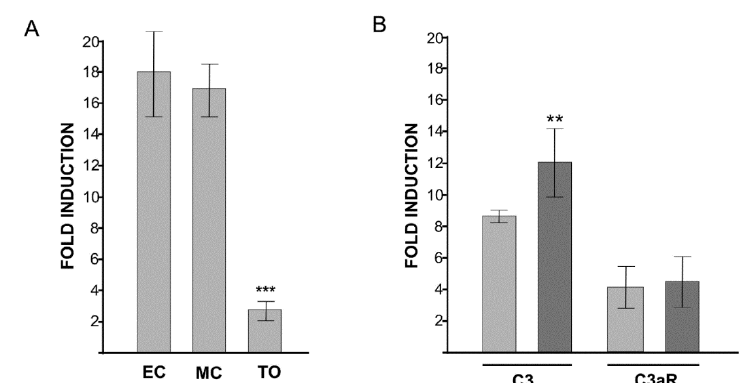
Figure 4. ( A ): level of bsc3a/c5ar transcription product in three phases of the colonial blastogenetic cycle as assessed by qRT PCR. EC: early cycle; MC: mid cycle; TO: takeover. ( B ): transcription of bsc3a/c5ar and bsc3 in colonies previously injected with C3aR agonist (dark grey bars) as compared to controls (light grey bars). Asterisks mark significant differences with respect to EC or the control (**: p < 0.01; ***: p < 0.001).